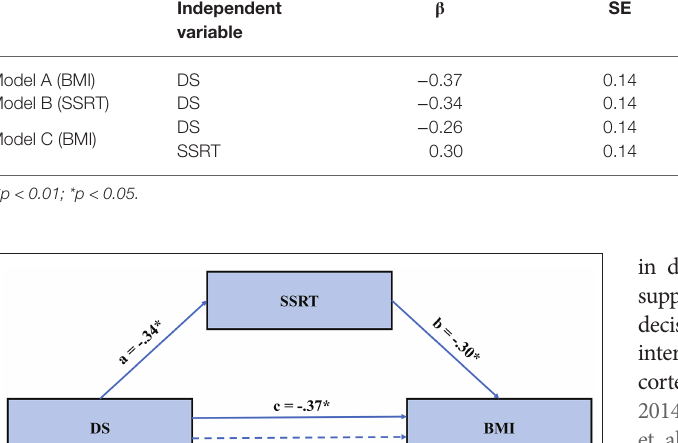
TABLE 3 | Mediation tests.